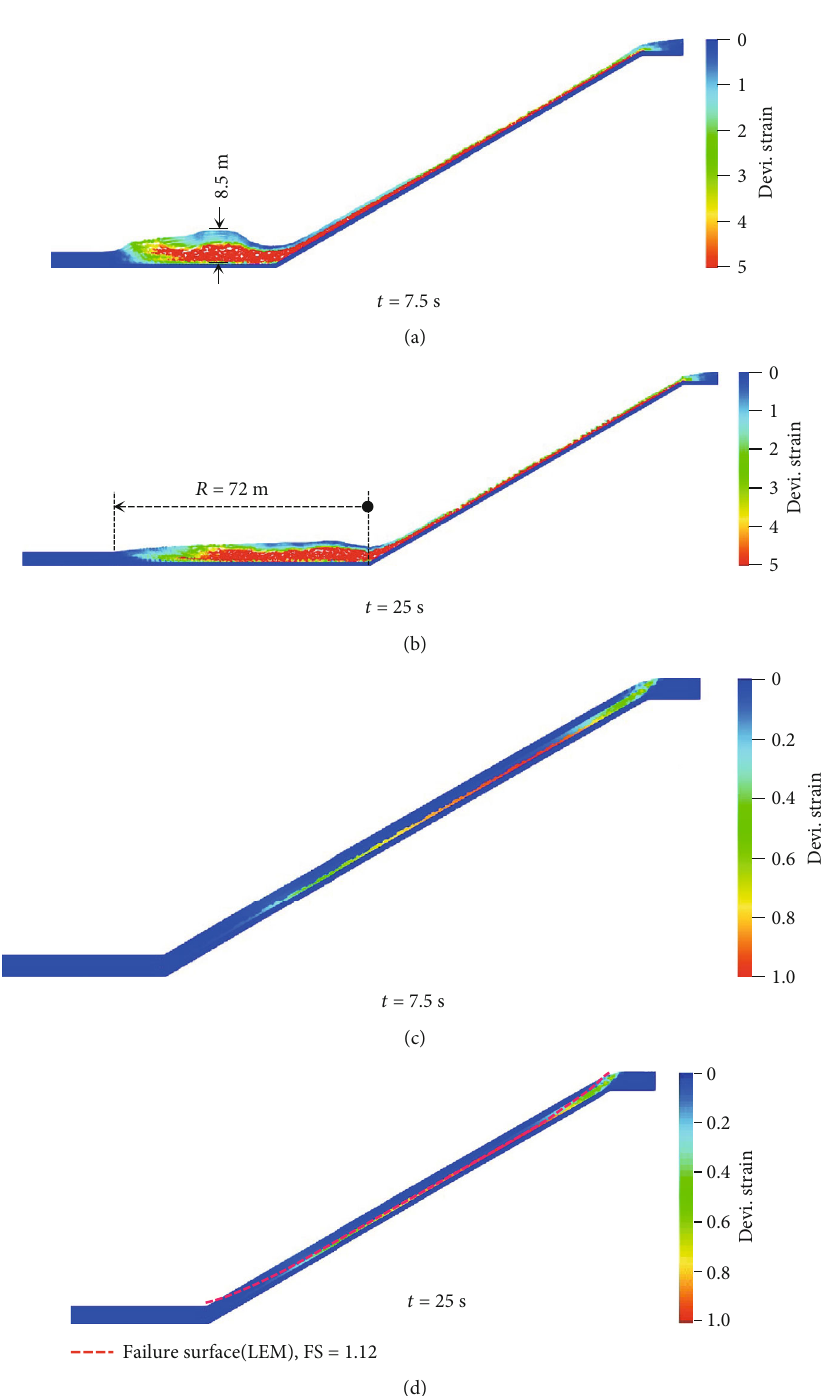
Figure 9: E ff ect of groundwater level on the post-failure behavior of a slope: (a, b) GWL1 and (c, d)